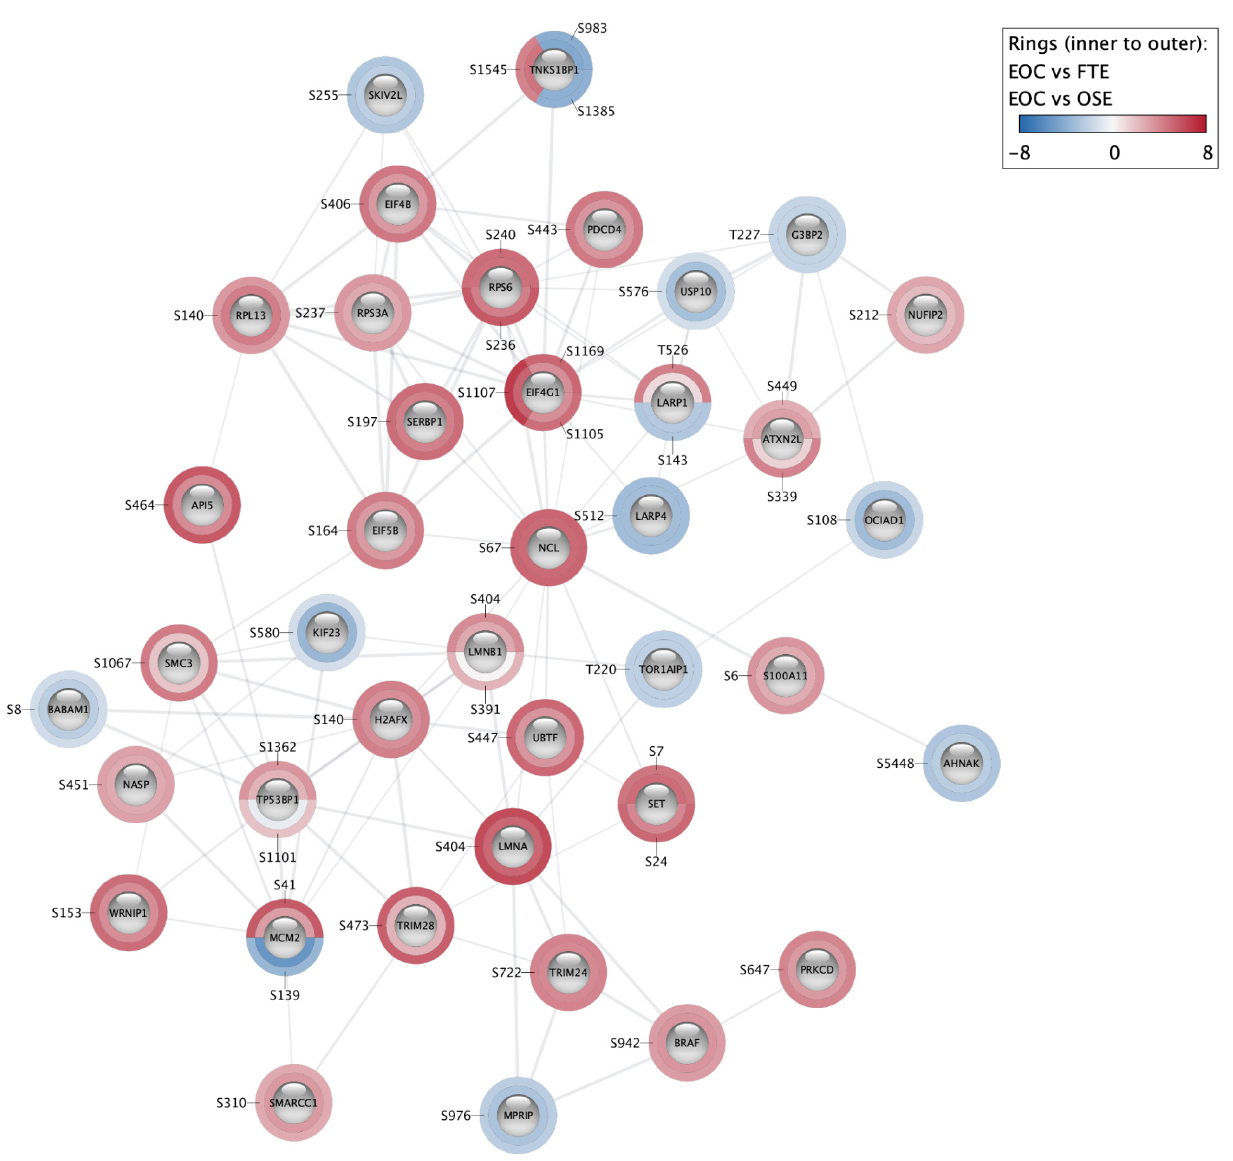
Figure 4. STRING network of proteins with significantly regulated phosphorylation sites detected in an ovarian cancer study 10 . Log-ratios of protein abundance between cancer and healthy tissues were mapped around the nodes using a blue–white–red gradient. Each slice of the rings represents a significantly regulated phosphorylation site. The inner ring is the comparison between epithelial ovarian cancer and distal fallopian tube epithelium (EOC vs FTE), the outer ring is the comparison between epithelial ovarian cancer and ovarian surface epithelium (EOC vs OSE). This subnetwork is the second biggest cluster obtained using Markov clustering on the STRING network of all proteins from the study that have at least one phosphorylation site with an adjusted p-value lower or equal to 0.01.